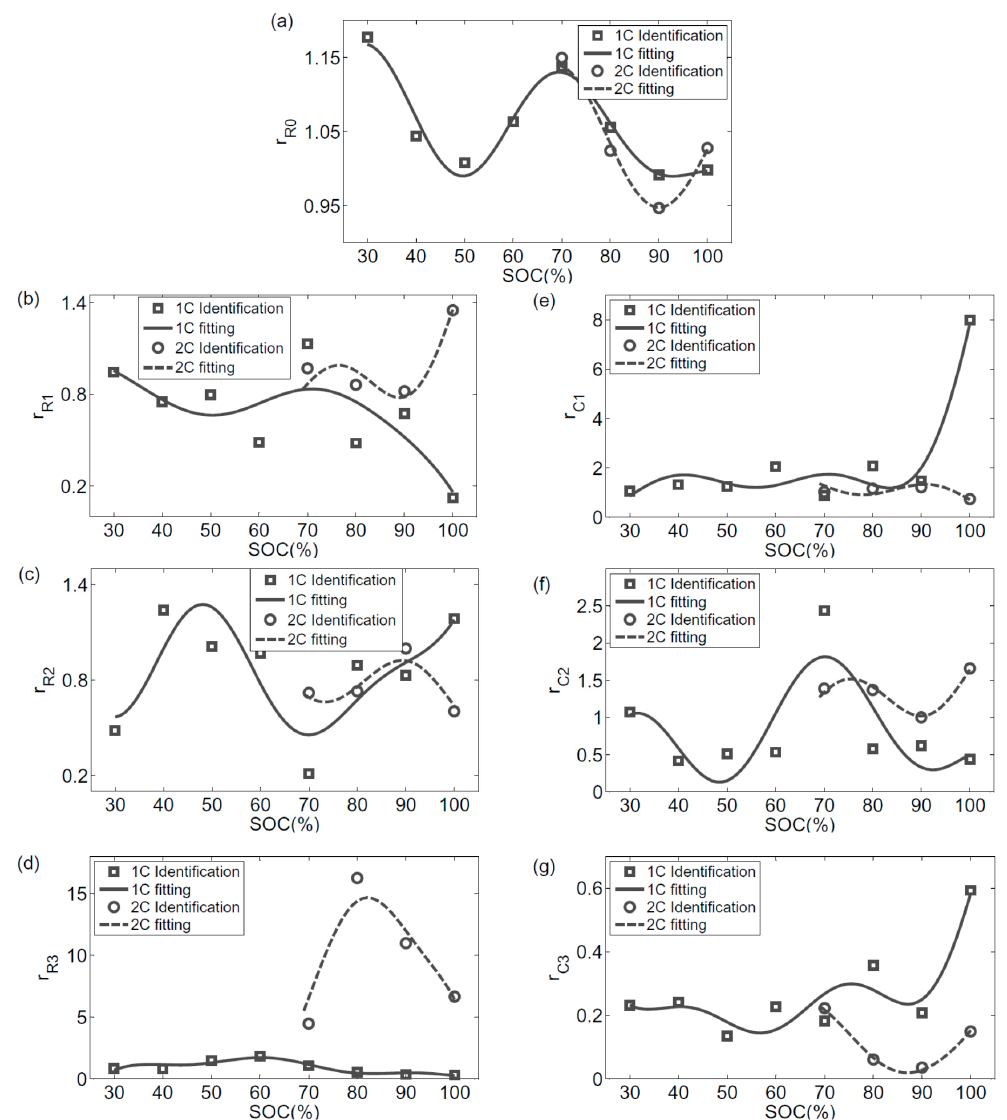
Figure 6. Battery model parameter ratios at 1 C and 2 C: ( a ) internal resistance ratio, r R0 ; ( b ) polarization resistance ratio, r R1 ; ( c ) polarization resistance ratio, r R2 ; ( d ) polarization resistance ratio, r R3 ; ( e ) polarization capacitance ratio, r C1 ; ( f ) polarization capacitance ratio, r C2 ; ( g ) polarization capacitance ratio, r C3 .